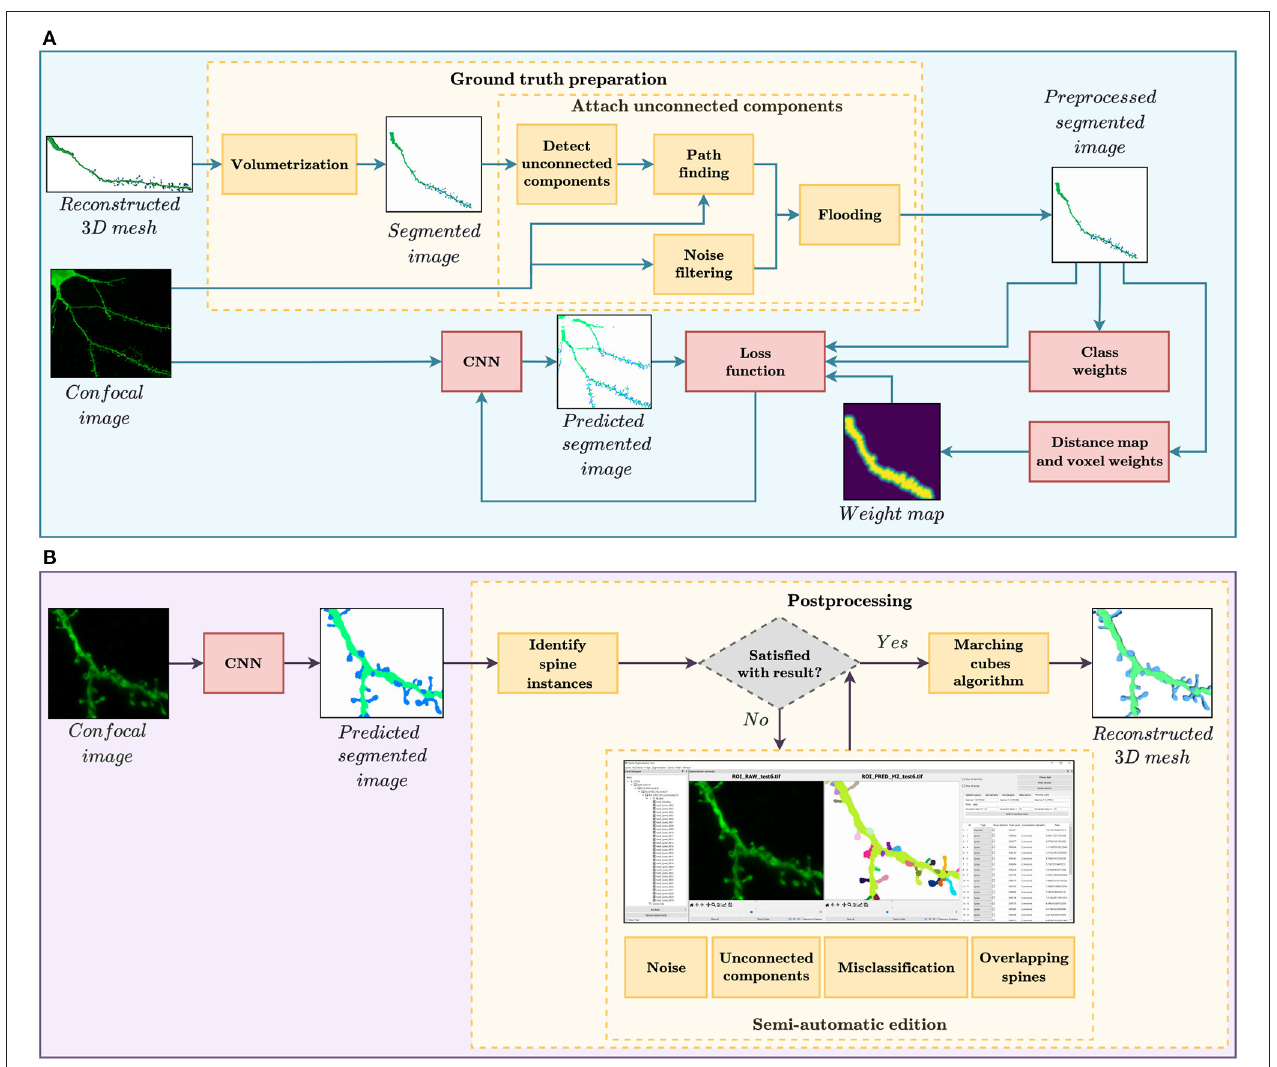
FIGURE 1 | (A) GT preparation and training workflow. The GT preparation steps are shown in yellow. First, the reconstructed 3D meshes of dendritic shafts and spines are transformed into a voxel-based segmented image. Then, unconnected parts of the dendritic shaft and its spines are detected and corrected automatically. Among other strategies, the loss function, used to train our convolutional neural networks (CNN), considers several types of class and pixel weights to alleviate training data set problems. (B) Automatic segmentation and postprocessing workflow. First, our CNN model provides a fully automatic segmentation. Then, the spine instances are identified. Users can then correct the CNN prediction through our GUI, if necessary. Finally, our system generates the 3D meshes of the segmented dendritic shaft and